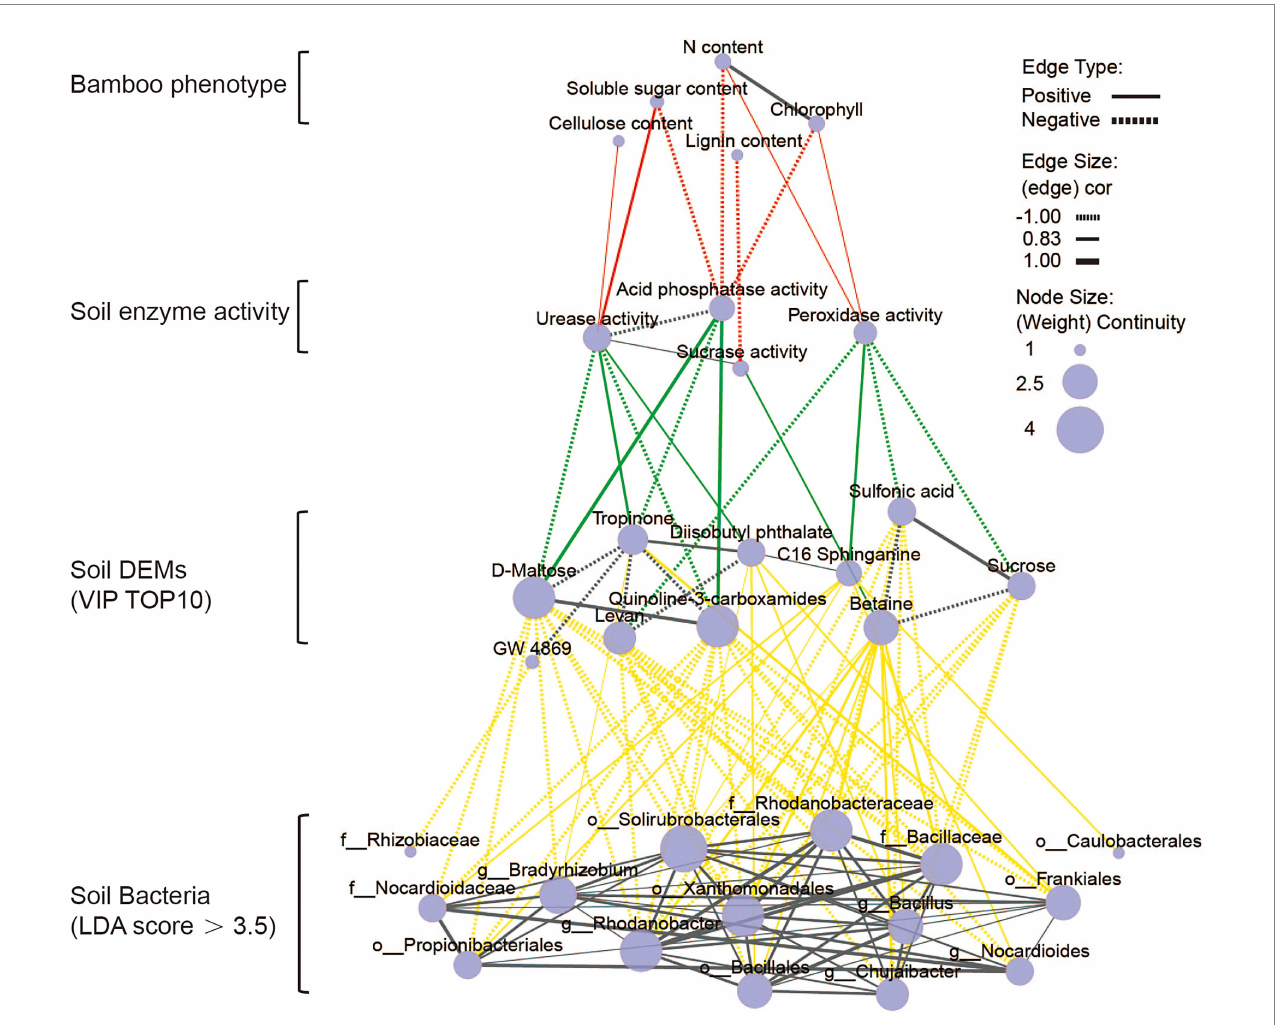
FIGURE 8 Correlation network between the Dendrocalamus farinosus growth phenotype and soil enzyme activity, soil differential metabolites (top 10 VIP value), and bacterial biomarkers (LDA Score > 3.5) following OFBa treatment (Spearman, p < 0.05). The solid line indicates a positive correlation and the dashed line indicates a negative